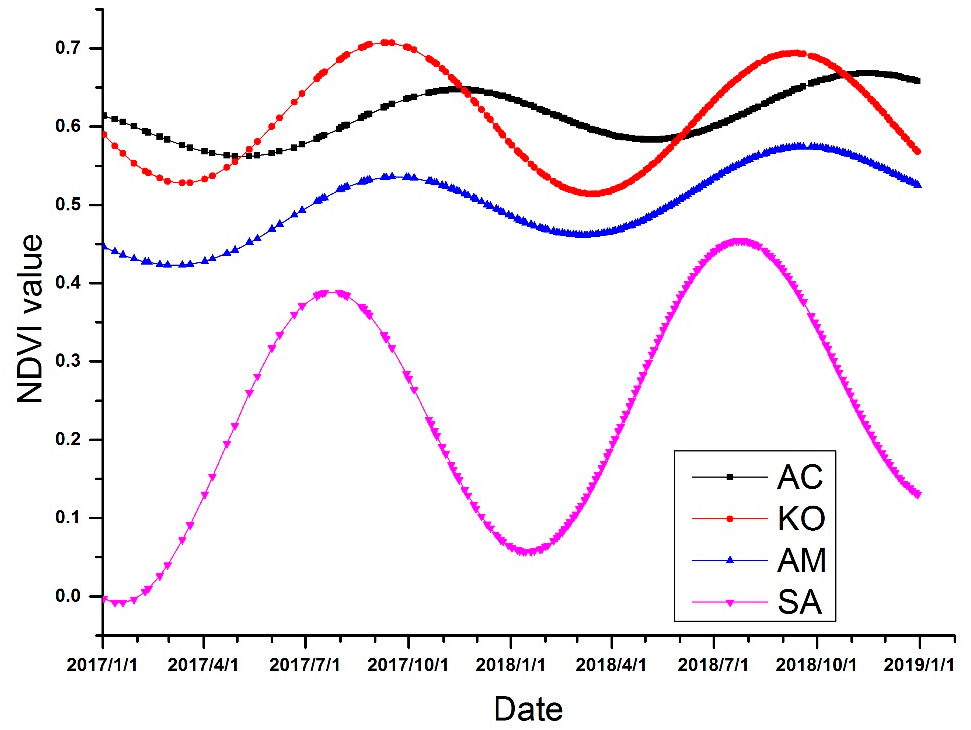
Figure 6. Typical time series NDVI profile established by harmonic analysis of time series (HANTS).